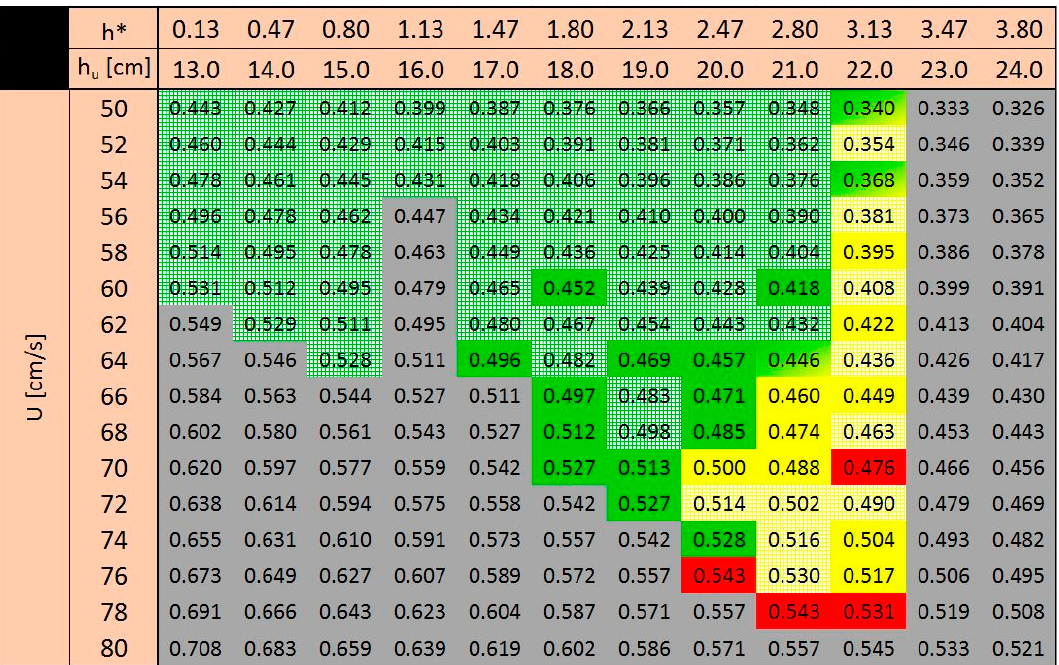
Figure 10. Results of the free standing deck experiments. Green cells indicate that no deck failure was observed, while red cells mean that failure occurred consistently across repeated tests. Yellow cells indicate critical conditions, i.e., the deck would be stable for some time (a few tens of seconds), but then collapse. Grey cells represent conditions that were above the maximum achievable Froude number or above a realistic inundation ratio. The number in each cell corresponds to the Froude number of that test. Light green and light yellow colors indicate that no specific experiments were conducted at these conditions, but an outcome was predicted based on the outcomes of neighboring experiments.